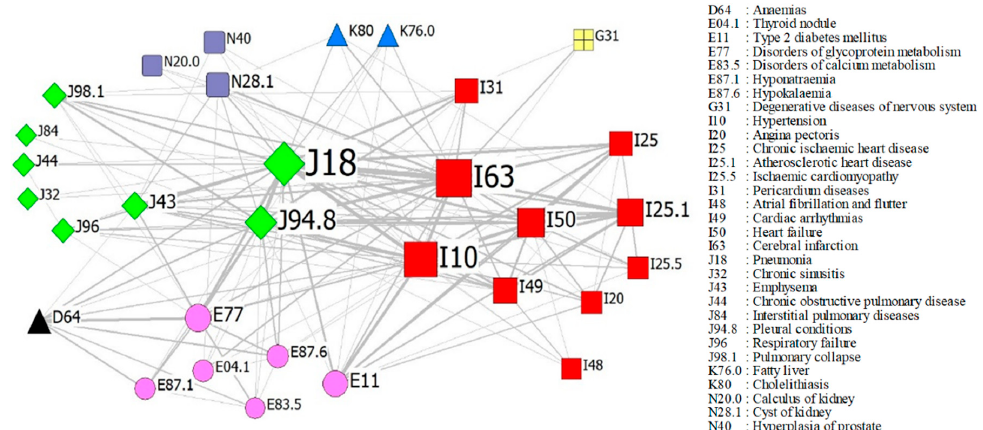
Figure 4. A network representation of comorbidities. Each node represents a disease, where nodes with the same shape denote a morbidity possessing the same International Classification of Diseases 10th revision (ICD-10) classification code, and an edge connects two nodes if patients were observed with this comorbidity. The size of a node is proportional to the frequency of the disease, and the width of an edge is proportional to the number of patients with the